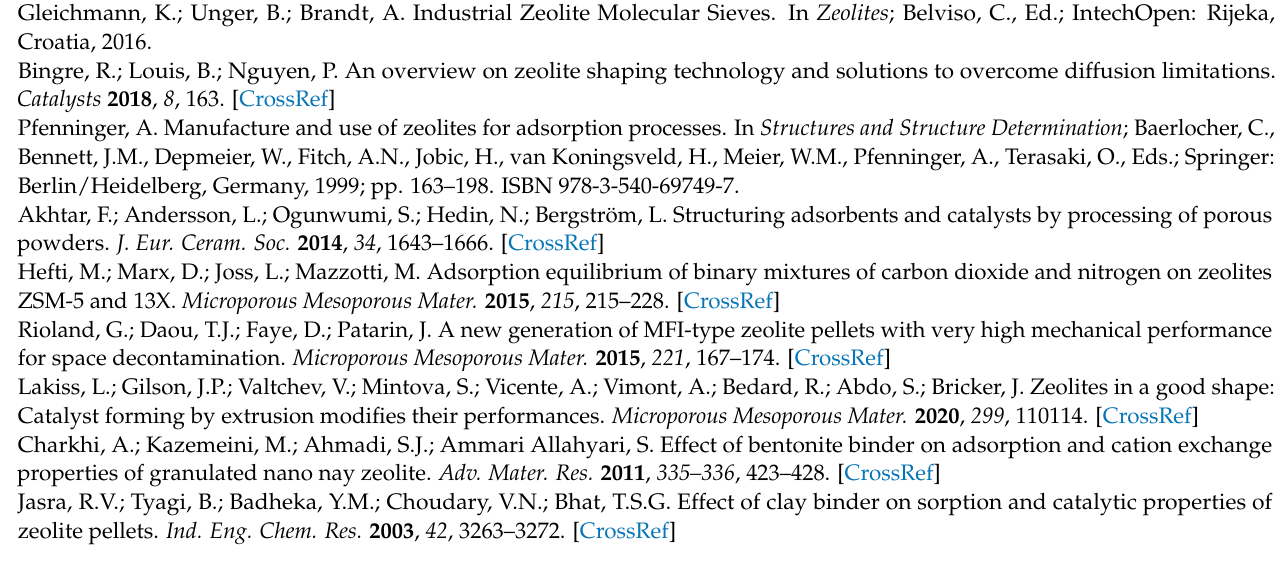
Figure S2. Comparison between X-ray diffractograms on the 13X zeolite samples. (a) shows the spectra from the 13X powder sample and (b) and (c) show the spectra from the 13X beads samples. Magenta lines indicate the theoretical peak position of the ICDD PDF2 data file of the FAU zeolite, black points indicate the theoretical peak position of the suggested SiO 2